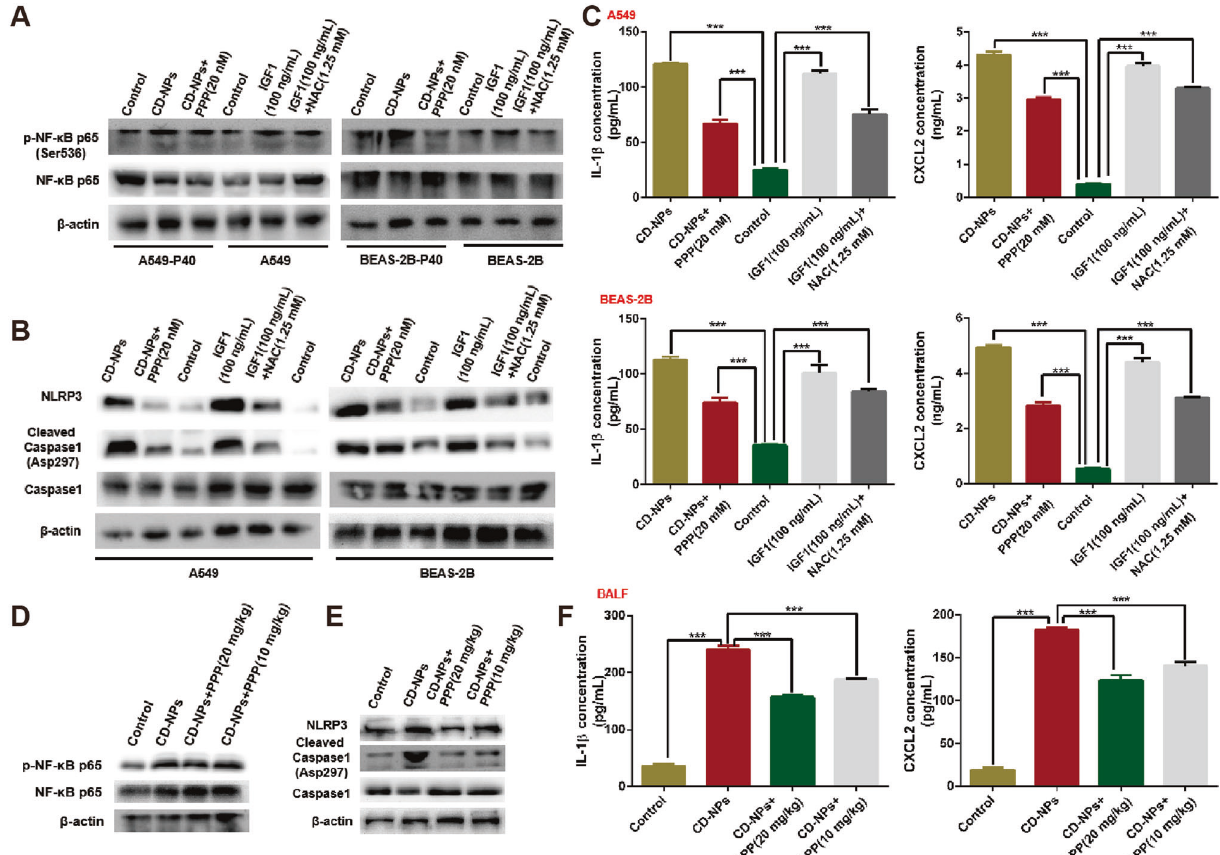
Fig. 6 Inhibition of IGF1/IGF1R signaling can alleviate CD-NPs-induced in fl ammation by inhibiting ROS-driven NF- κ B/NLRP3 pathway. A , B The activation level of NF- κ B/NLRP3 pathway was detected by western blot in vitro. C In fl ammatory factor IL-1 β and in fl ammatory chemokine CXCL2 in the supernatant of alveolar epithelial cells were detected by ELISA. Data were expressed as the mean ± SD, n = 3. *** P < 0.001. D , E The activation level of NF- κ B/NLRP3 pathway was detected by western blot in vivo. F In fl ammatory factor IL-1 β and in fl ammatory chemokine CXCL2 in mouse bronchoalveolar lavage fl uid (BALF) were detected by ELISA. Data were expressed as the mean ± SD, n = 3. *** P <